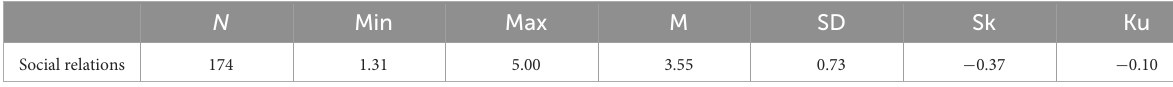
TABLE 3 Descriptive data for the Scale of Relations in the Institution . N Min Max M SD Sk Ku 3.55 0.73 − 0.37